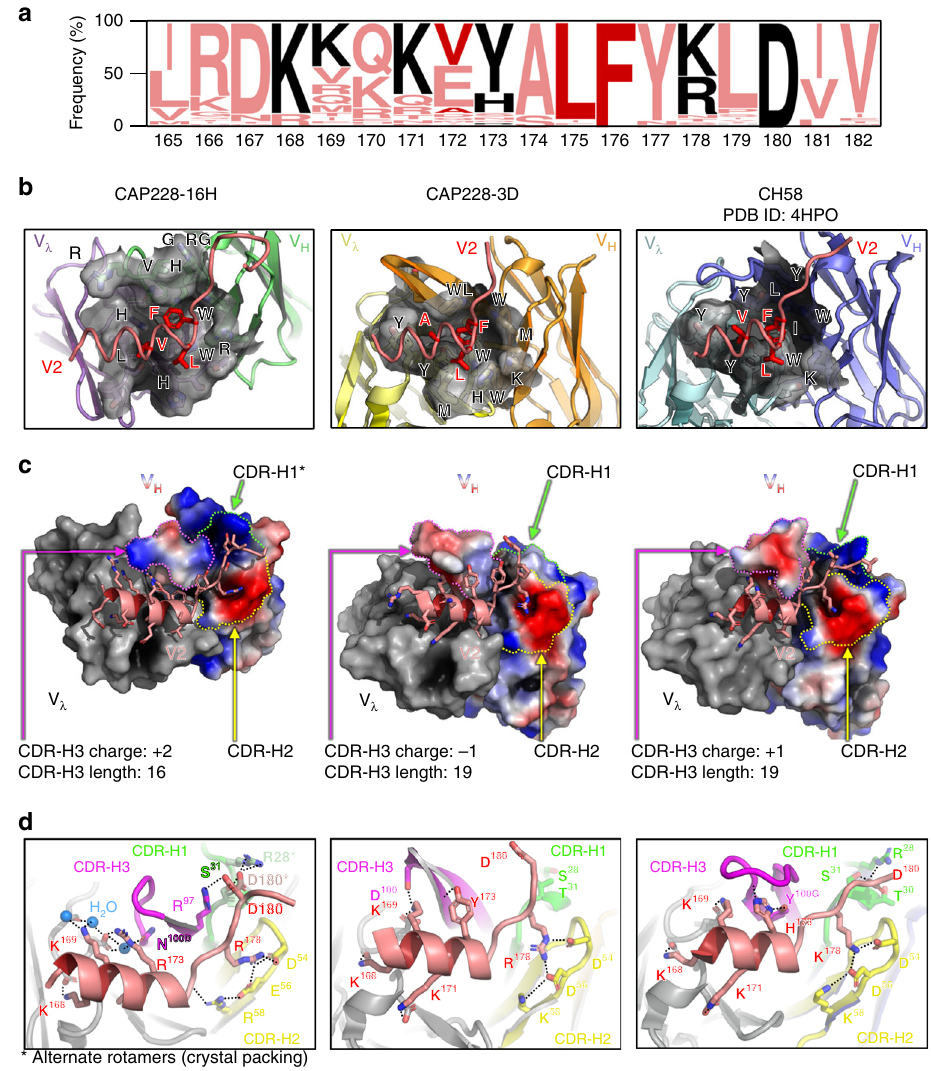
Fig. 2 IGHV5-51 V2p mAbs de fi ne a binding class with a distinct mode of recognition. a Logogram of global V2 sequences in the HIV-1 LANL database, showing the relative amino acid frequencies ( y -axis) at each position in V2 ( x -axis, residues 165-182). Key hydrophobic amino acids bound by IGHV5-51 antibodies are highlighted in darker red, while other key contact residues are coloured black. b A cartoon representation of the three IGHV5-51 V2p Fab paratopes (coloured as in Fig. 1), with the central hydrophobic binding depression shown in surface view. Heavy and light chain residues that make up the hydrophobic binding area are indicated, and the side chains are shown for key buried V2 residues 172, 175 and 176. c The solvent accessible surfaces of the heavy and light chain variable domains from all three mAbs are shown and labelled. The light chains are coloured dark grey, while the heavy chains are coloured on a smoothed charge gradient with more electronegative regions in red, and more electropositive surfaces in blue. The heavy chain complementarity determining regions 1, 2 and 3 are encircled with green, yellow and pink dotted lines, respectively, and the CDR-H3 lengths and overall charges are indicated. V2 peptides are shown in stick and cartoon views. A single rotamer change to account for crystal packing is indicated by the asterisk. d Atomic level details of the interaction between all three IGHV5-51 mAb heavy chains and V2, with the CDRs coloured as in c . Hydrogen bonds are indicated with the dotted black lines, and key water molecules are shown with blue spheres. Alternative rotamer conformations for V1V2 residue D180 and CDR-H1 residue R28 (in fl uenced by crystal packing in the CAP225 bound structure) are shown and labelled with at the V1V2 termini (provided here by scaffolding onto 1FD6), the V2p epitope was ef fi ciently captured by CAP228-16H in the same helix-coil con fi guration normally presented by short V2 peptides (Fig. 4a – shown in red). Both the primary α 4 β 7 binding site at position D180 (Fig. 4 – gold spheres) and the potential secondary α 4 β 7 binding determinant that includes position K171 (Fig. 4 – silver spheres) were colocalized in the CAP228-16H paratope. Electron density for V2 residues bound by CAP228- 16H was clearly de fi ned and matched well with the higher resolution V2 peptide cocrystal structures (Supplementary